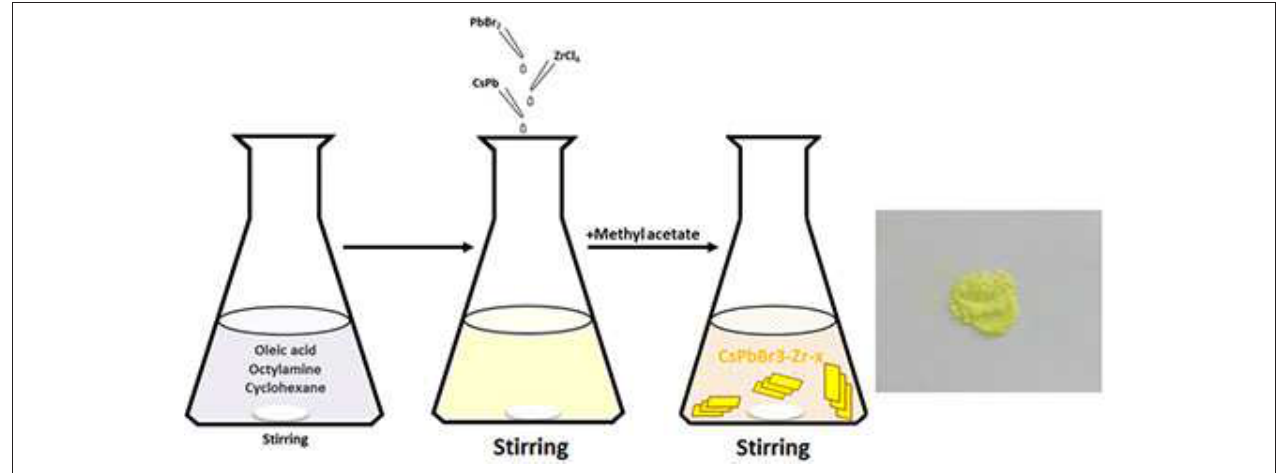
FIGURE 1 | The schematic of the synthesis and photographs under visible light of ZrCl 4 -CsPbBr 3 /Cs 4 PbBr 6